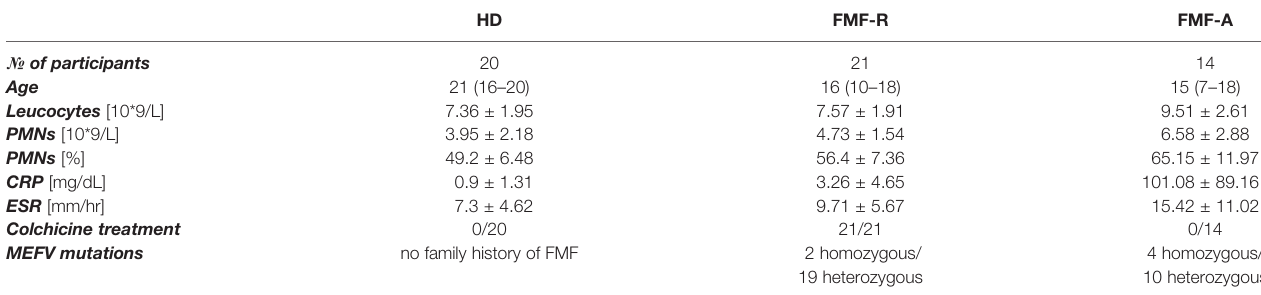
TABLE 1 | Demographic and clinical characteristics of FMF patients and healthy